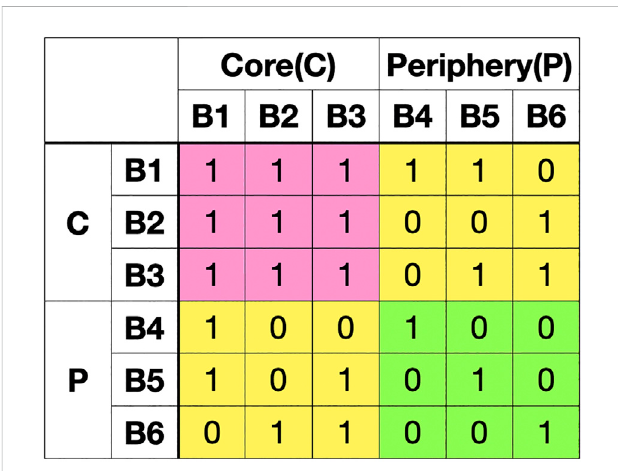
FIGURE 2 ExampleofCC,PP,andPC(CP)blocksintheboardnetworkattime t. Each B1 – B6 denotes the company ’ s board of directors. When B1 and B2 have sharing directors, they are connected and designated by 1. A board of directors in the pink range is considered a CC (core – core) block. In other words, the boards in a CC block have connection with other boards. A board of directors in the green range is considered a PP (peripheral – peripheral) block. A board of directors in the yellow range is considered PC (peripheral – core) and CP (core – peripheral) blocks because the board of the director network is symmetric, so PC and CP blocks are the